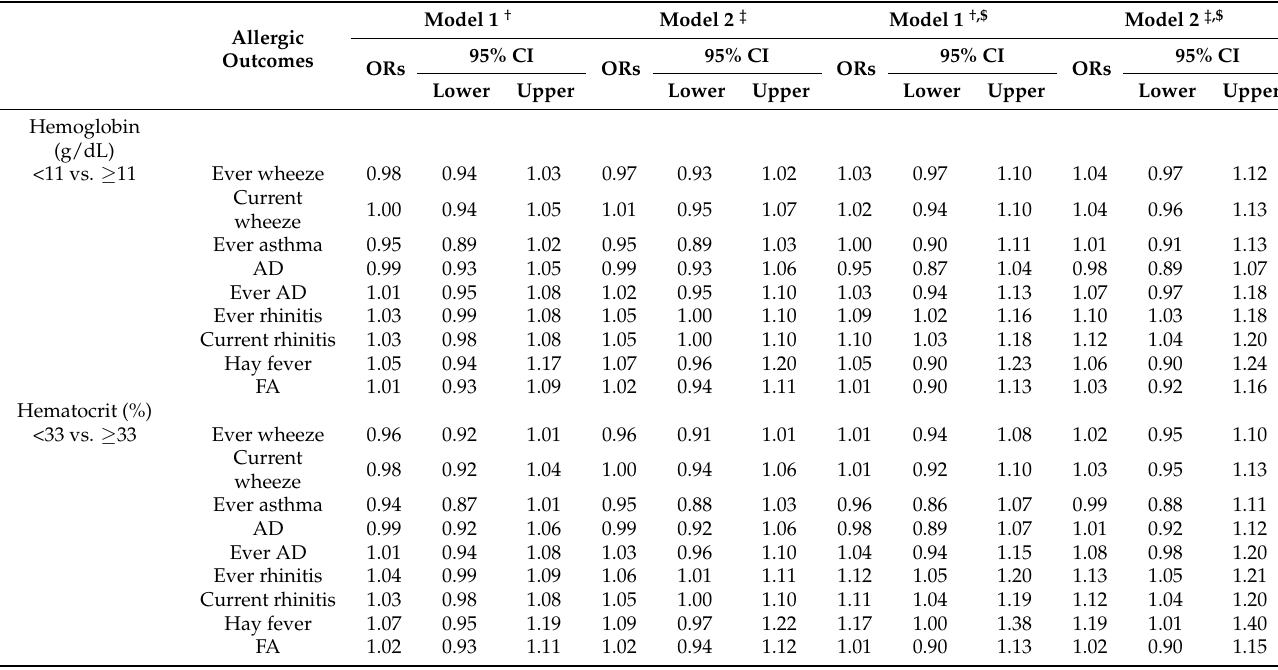
Table 1. Associations of maternal hemoglobin and hematocrit concentrations with allergic outcomes among children at age 3 years. Allergic